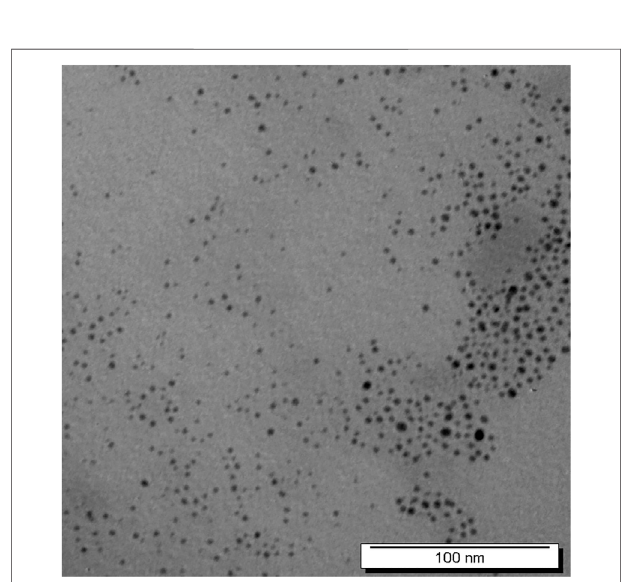
FIGURE 3 | TEM image of